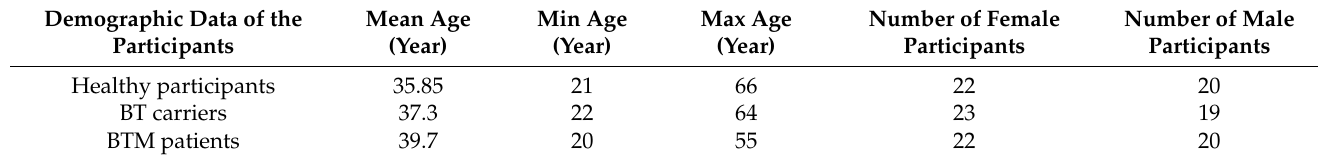
Table 1. Demographic data of the